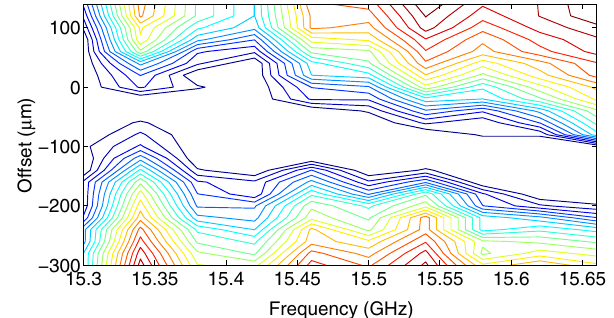
FIG. 44. Signal output measured by the upstream wakefield monitor at different frequencies for a varying structure offset. The structure is tilted on purpose by an angle of 0.5